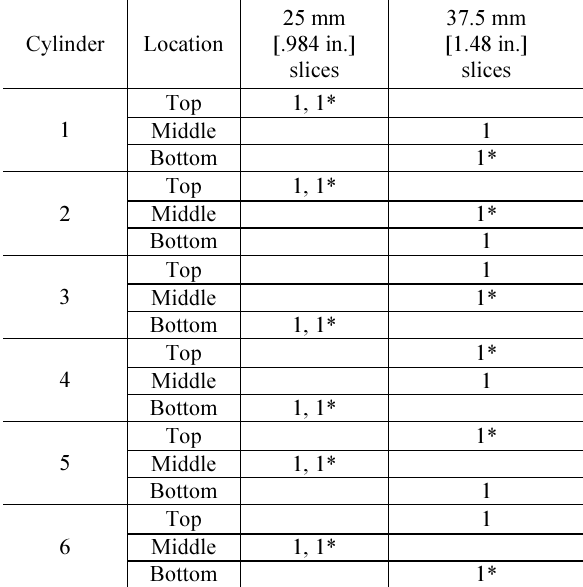
Table 2. Test matrix for cylinders: 1 = one non-heat treated sample, 1* = one heat treated